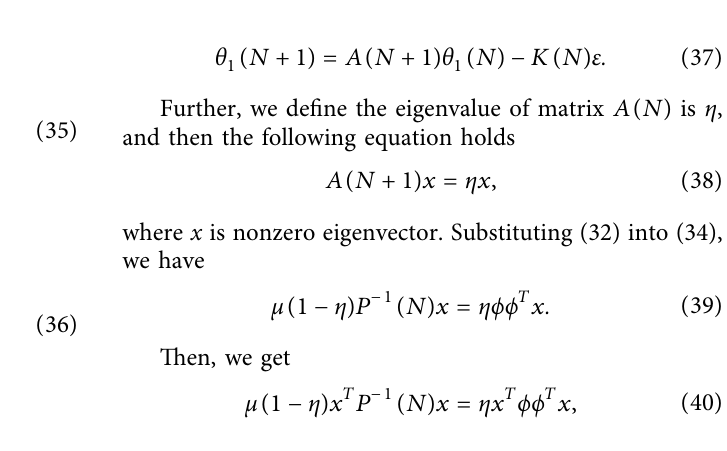
Figure 2: Parameter estimation variation